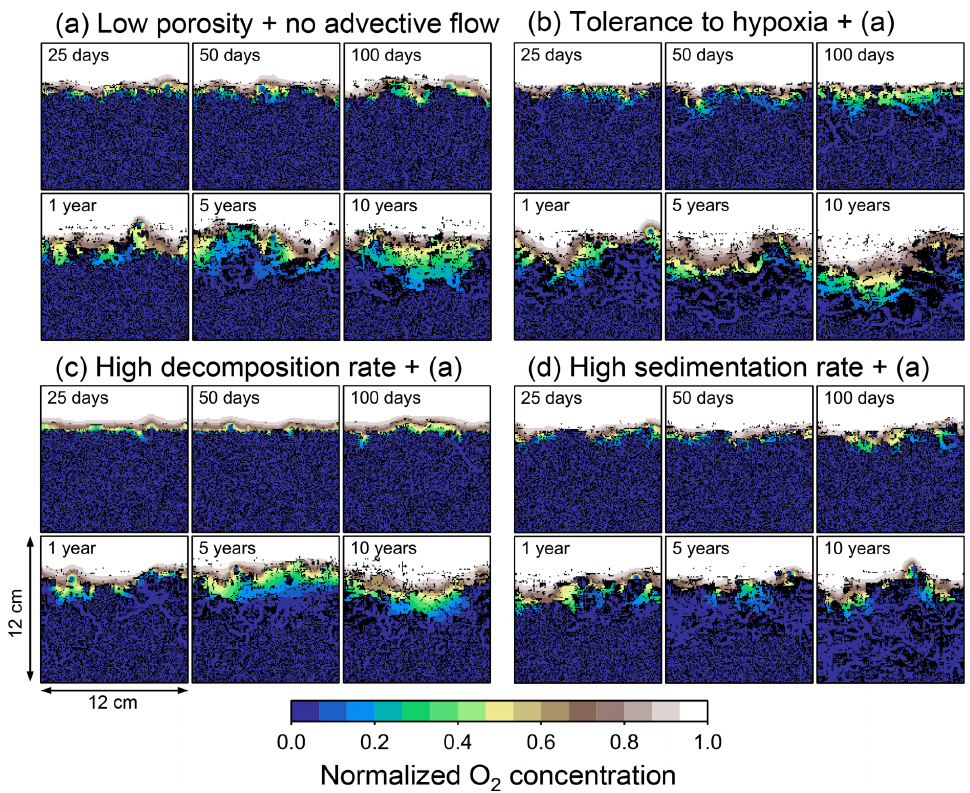
Figure 8. Time evolution of oxygen profiles calculated from 10-year simulations with eLABS. Four different simulations were conducted (Sect. 3.2): (a) with low porosity and no advective water flow but otherwise default settings, (b) additionally assuming organisms to have tolerance to oxygen-depleted conditions, (c) with 10 × higher rate for aerobic decomposition of organic matter but otherwise the same settings as in panel (a) , and (d) with 10 × higher sedimentation rate but otherwise the same settings as in panel (a) . Shown are the profiles of oxygen concentration normalized to the constant boundary value (2 . 2 × 10 − 4 molL − 1 ) at the top layer of the grid at 25, 50, and 100 model days and 1, 5, and 10 model years from the start of the